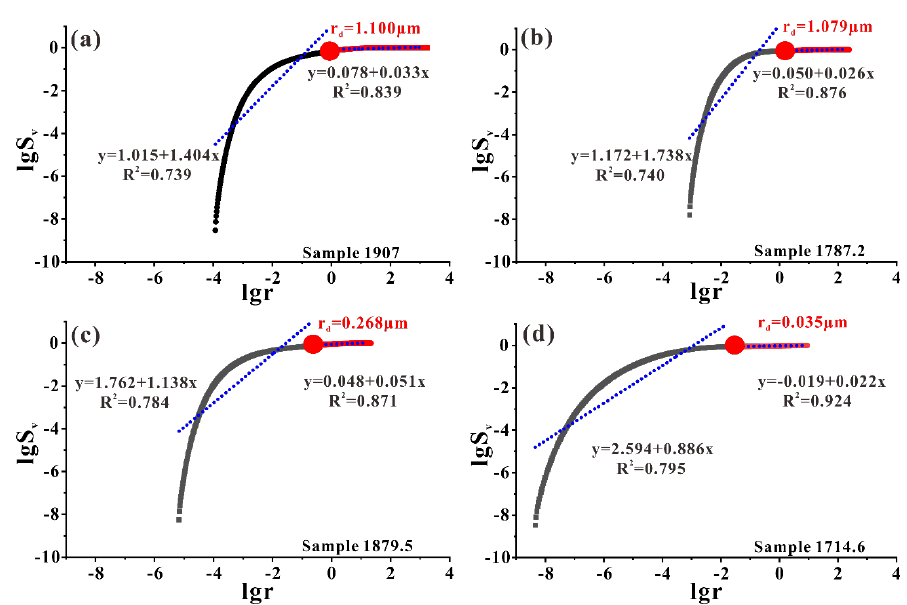
Figure 8. Fractal dimension analysis from NMR-HPMI derived PSD of four selected representative sandstone samples for the ( a ) QCDF, ( b ) ACMF, ( c ) CCF, and ( d ) MCTF. Table 4. The characteristics of fractal dimensions in the J 1 b sandstone samples derived from NMR-HPMI-integrated curves.